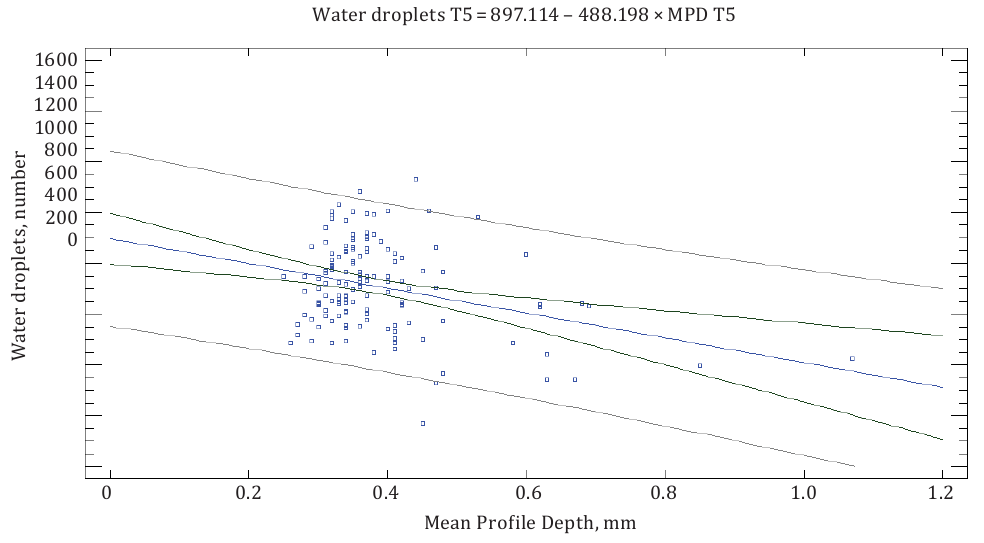
Mean Profile Depth,